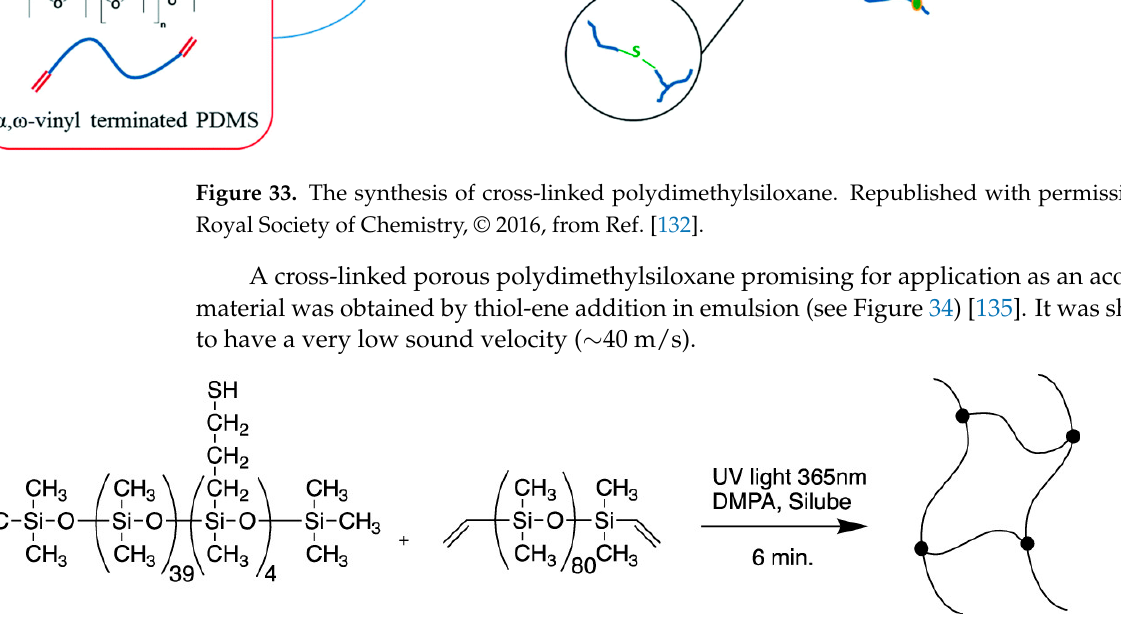
Figure 34. The synthesis of a cross-linked polydimethylsiloxane by hydrothiolation. Re- printed/adapted with permission from Ref. [135]. Copyright 2020 American Chemical Society.